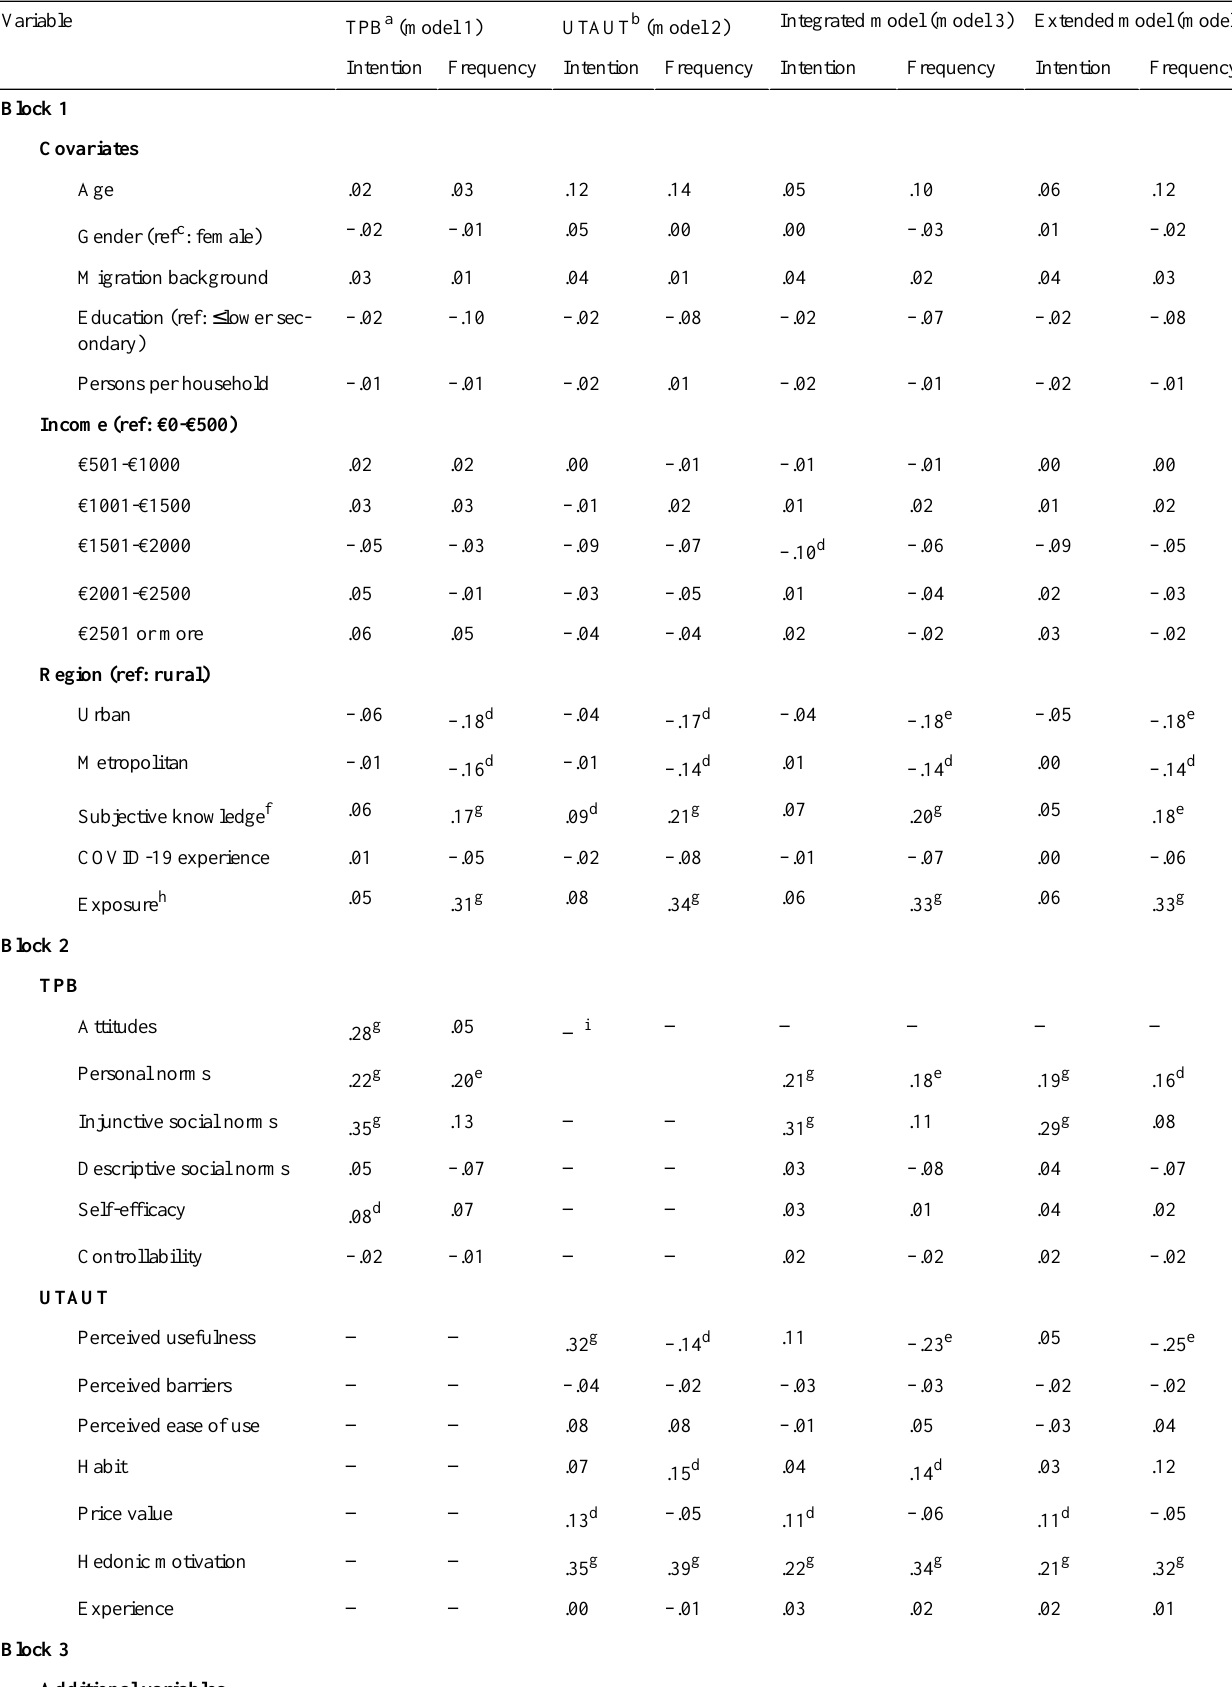
Table 3. Standardized regression weights and explained variance of hierarchical regression models predicting adoption intentions and frequency of current contact tracing app